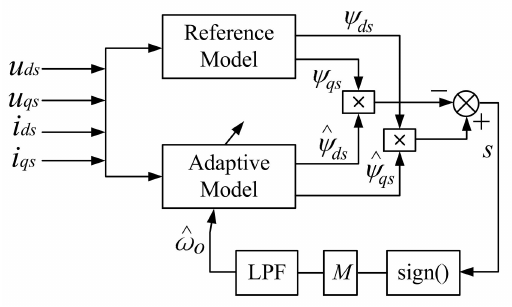
Figure 4. Configuration of the SM-MRAS based on the flux